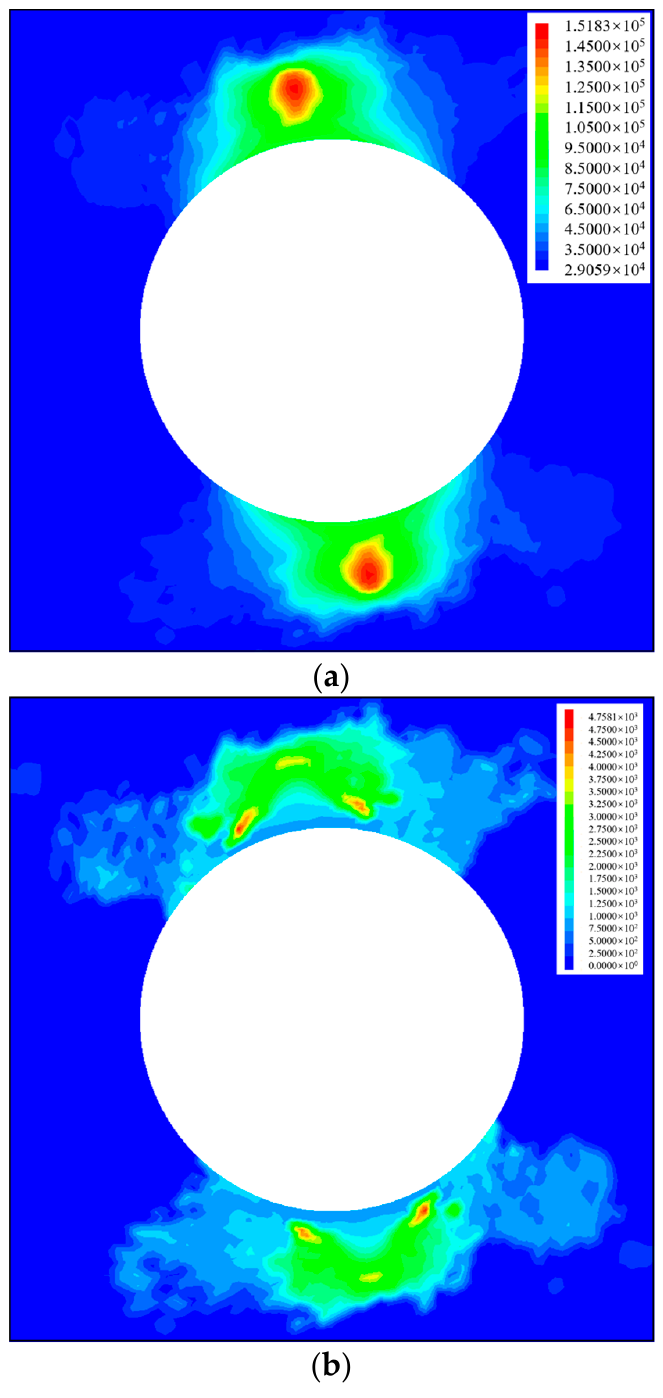
Figure 6. The maximum energy density and its occurrence time before the energy